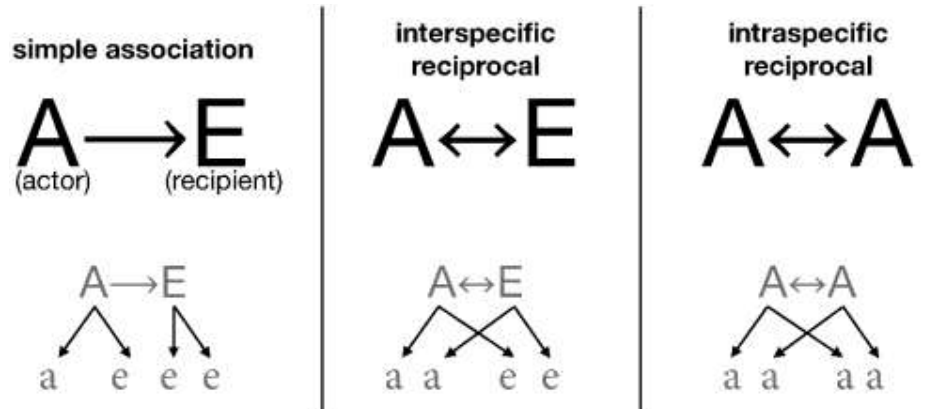
Figure 1. Class of associations. Chart of the type of associations among digital organisms. A and E are organisms with their offspring (a and e, respectively). The arrows indicate the direction in which the resources are delivered.